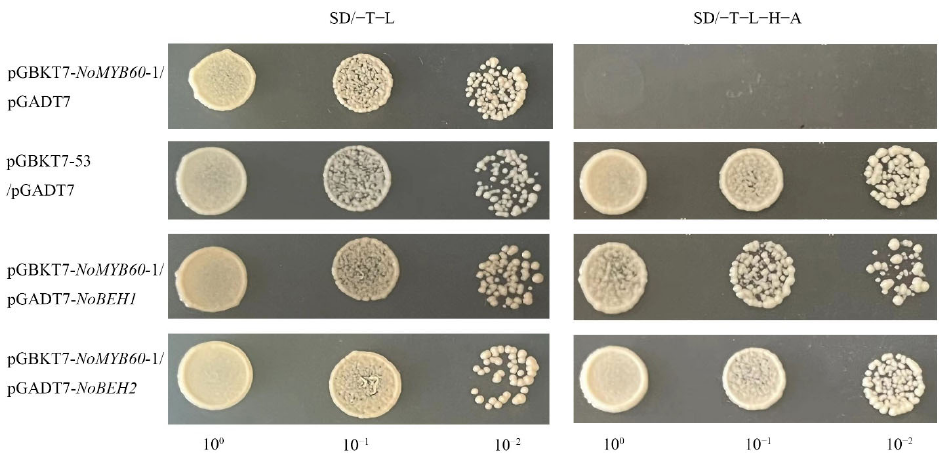
Figure 8. Yeast two-hybrid analysis of interaction between NoMYB60 and NoBEH1/2. The verification of the interaction between NoMYB60-1 and NoBEH1/2 by Y2H assay. The yeast cells were grown on the SD media: SD/ − T − L (left), SD/ − T − L − H − A (right). pGBKT7-53/pGADT7 were used as the positive control. 10 0 , 10 − 1 and 10 − 2 represent the concentrations of yeast solutions.